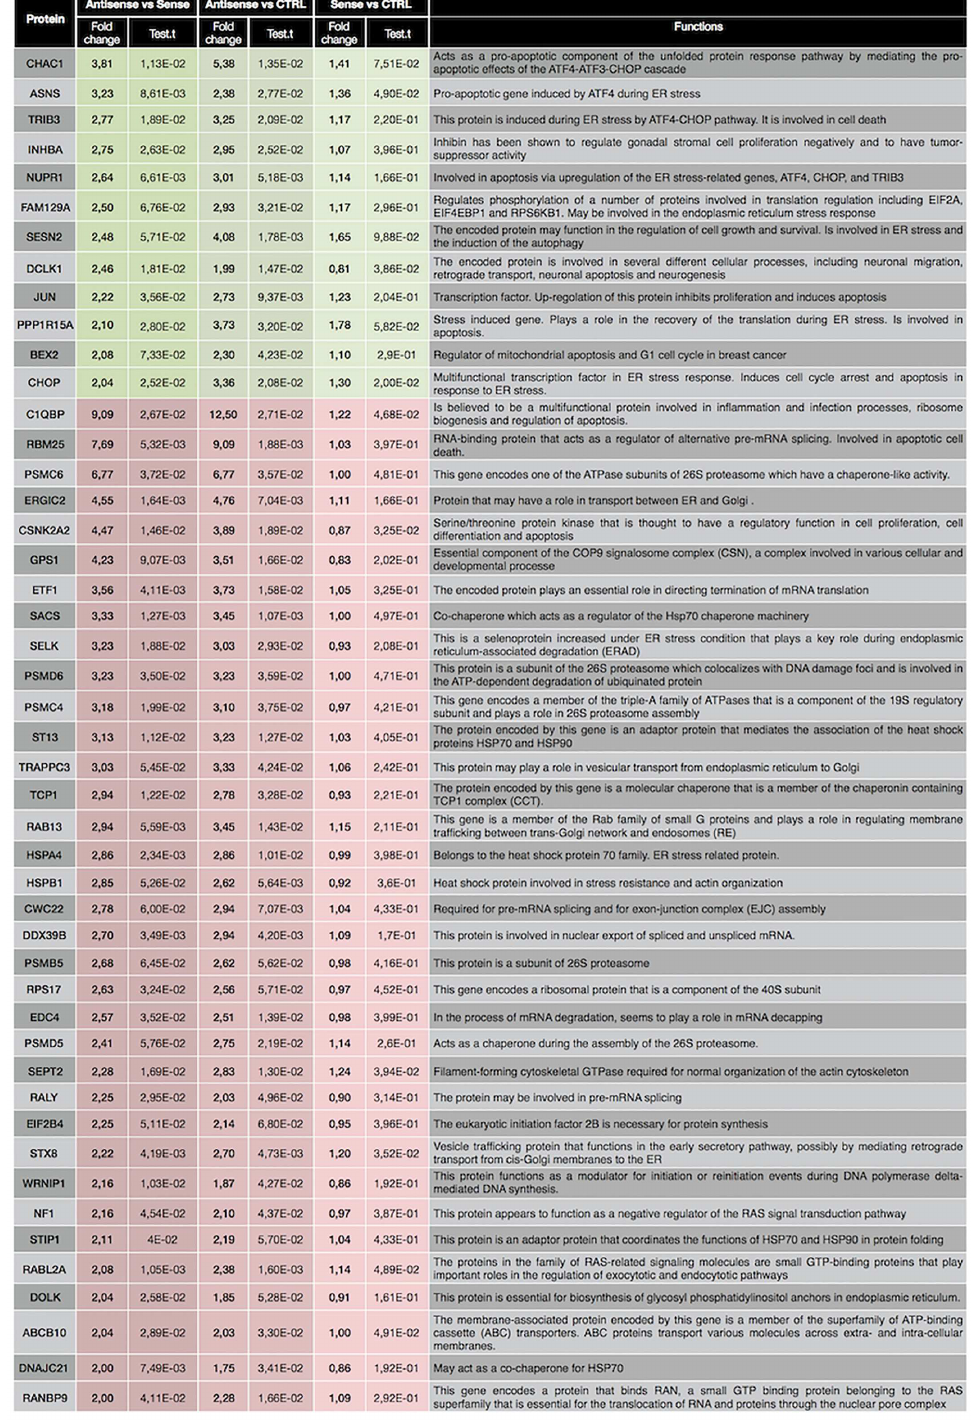
Fig 4. Filtered list of genes which showed a fold change > 2 (ASO vs SO) in the microarrayanalysis at 12h, and belonged to the top GO terms listed in Table 1.